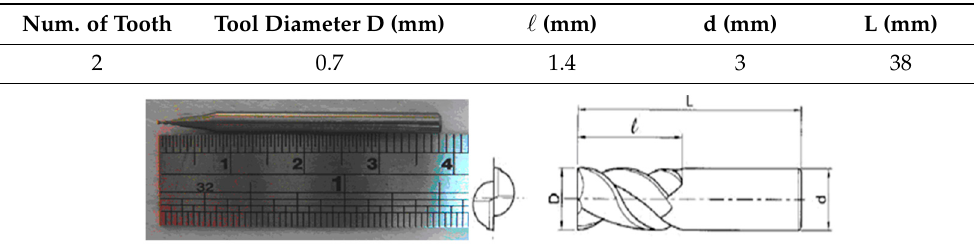
Table 2. Composition of SK2 workpiece.